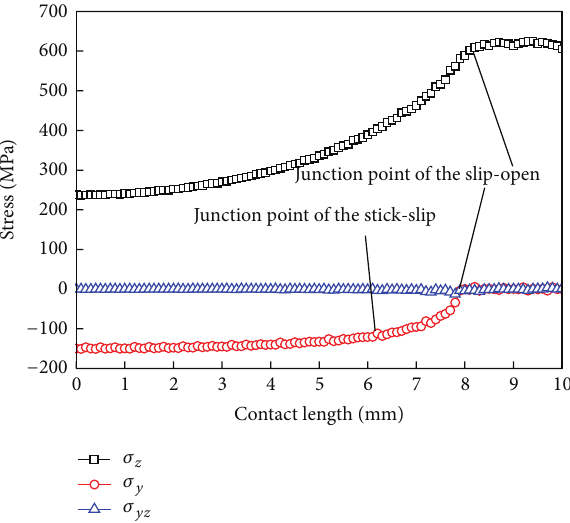
Figure 7: The normal contact stress distribution under different hollow degrees.